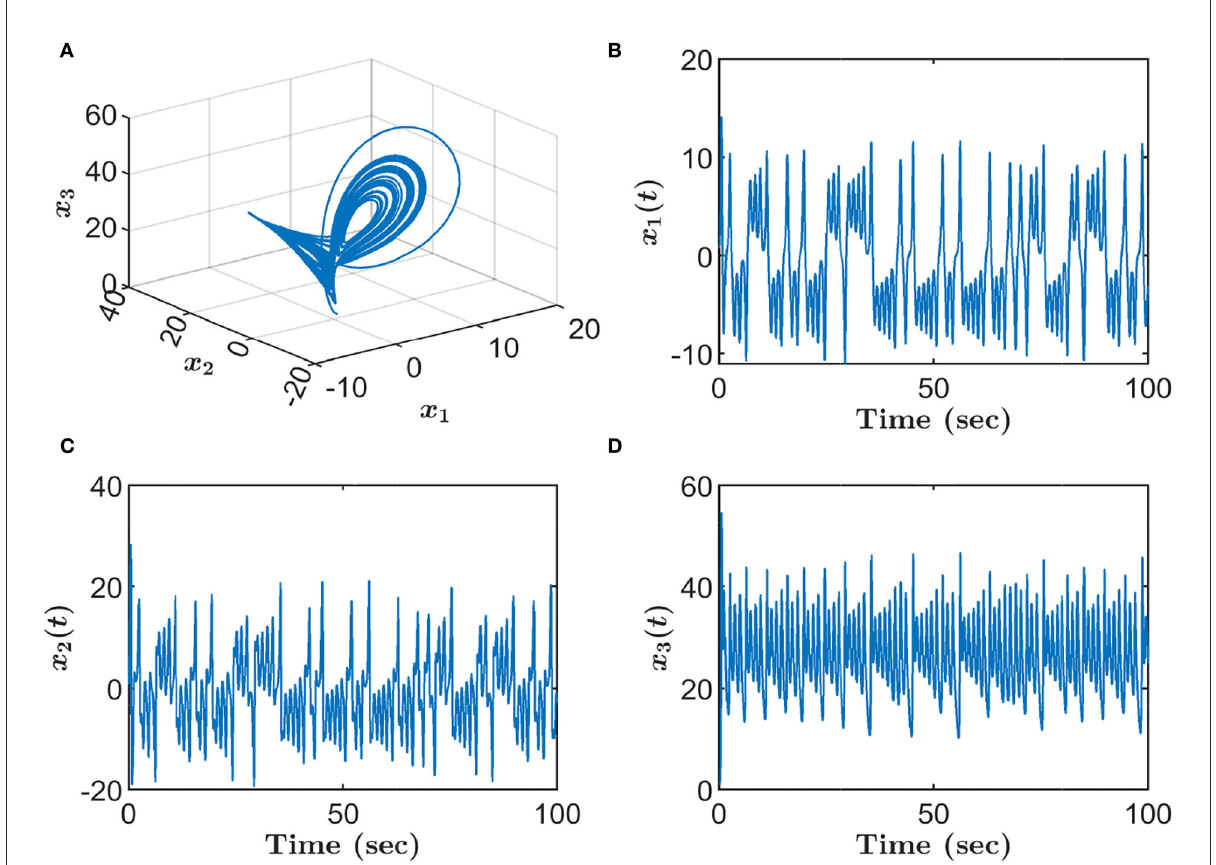
FIGURE1 Chaotic attractor of fractional-order PMSM with β = 0.98, σ = 3, and γ = 30. (A) 3D phase portrait. (B) Time evolution of x 1 . (C) Time evolution of x 2 . (D) Time evolution of x 3